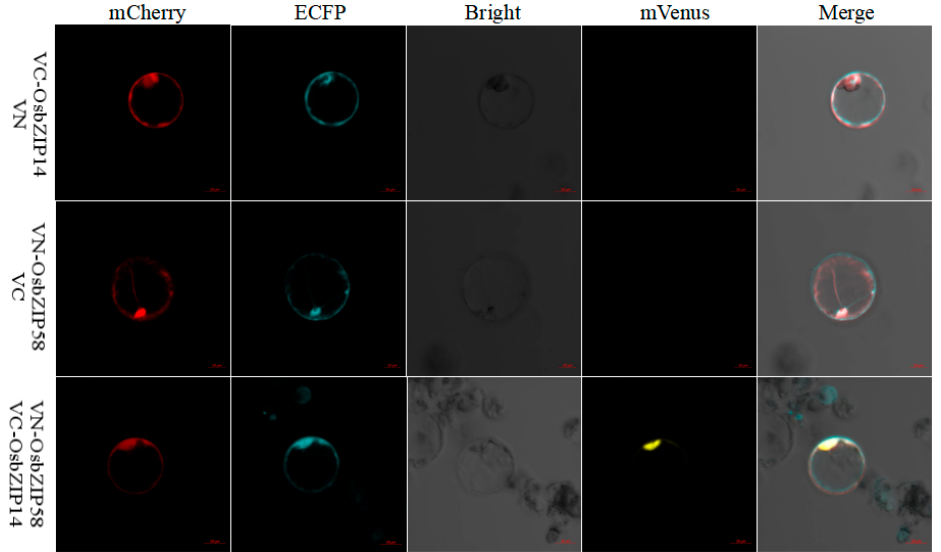
Figure 8. Detection of the interaction between OsbZIP14 and OsbZIP58 using BiFC. BiFC results showed a yellow fluorescence signal in rice protoplasts with the co-expression of the N-OsbZIP58/C- OsbZIP14, indicating a direct interaction between OsbZIP14 and OsbZIP58 (Scale bar represents 10.0 µ